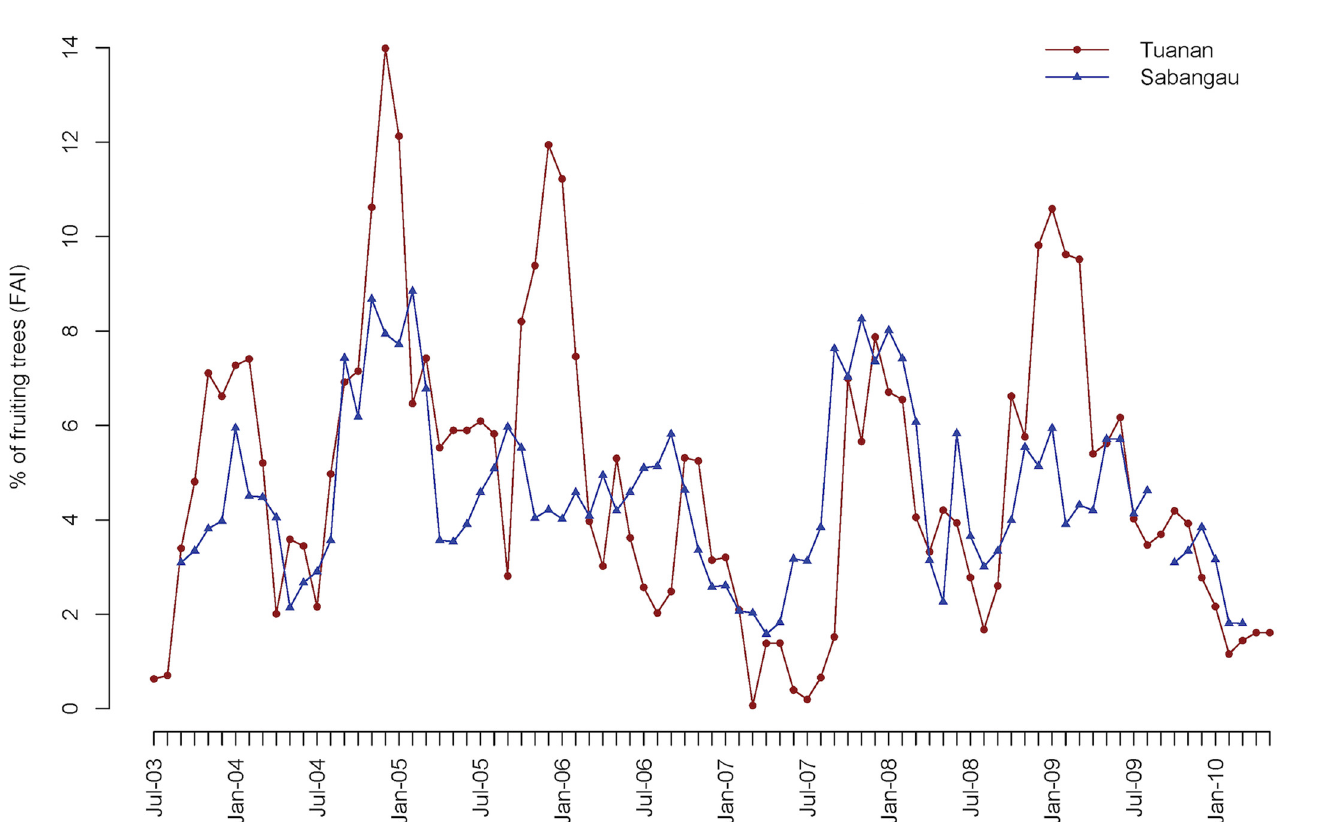
Fig 4. Percentage of fruiting trees over the entire study period in Tuanan (red) and Sabangau